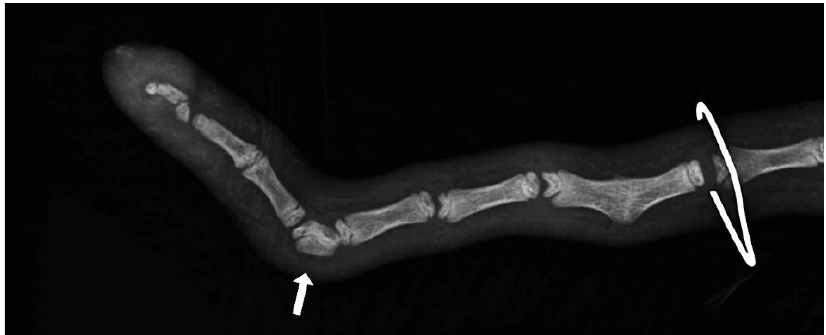
Figure 3. Section of an X-ray of a lamb’s tail with a wedged vertebra.